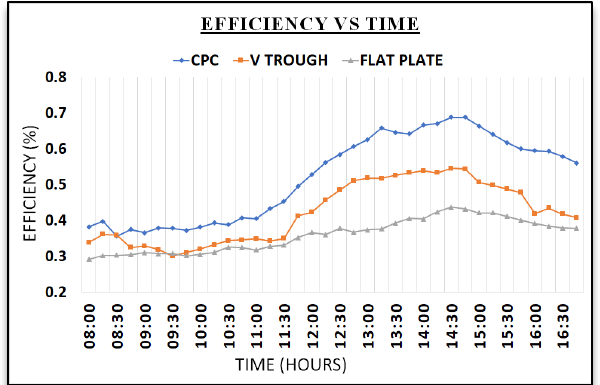
Figure 18. Efficiency vs Time values observed for the Flat plate, V Trough and CPC